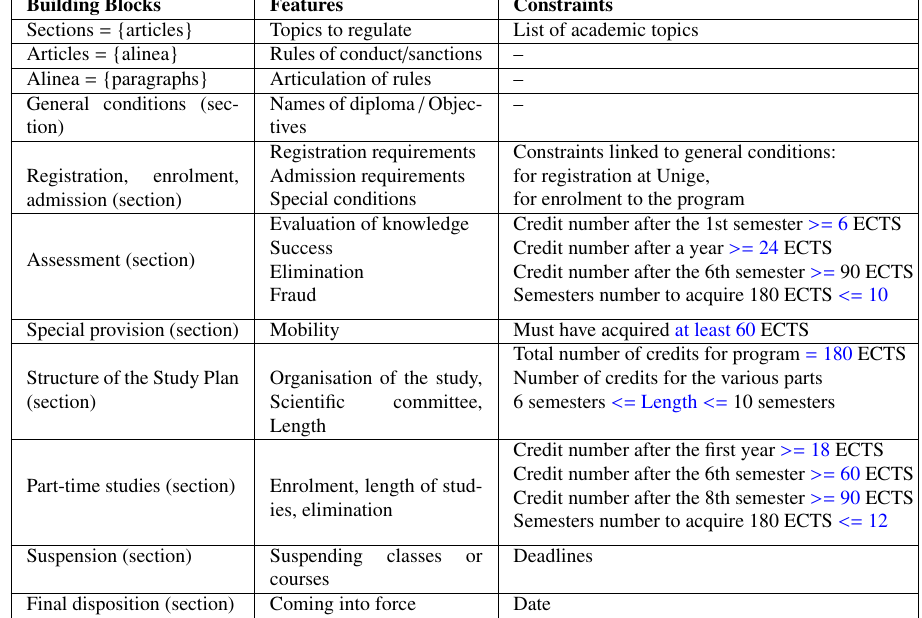
Table 3: Building blocks - Study Regulation